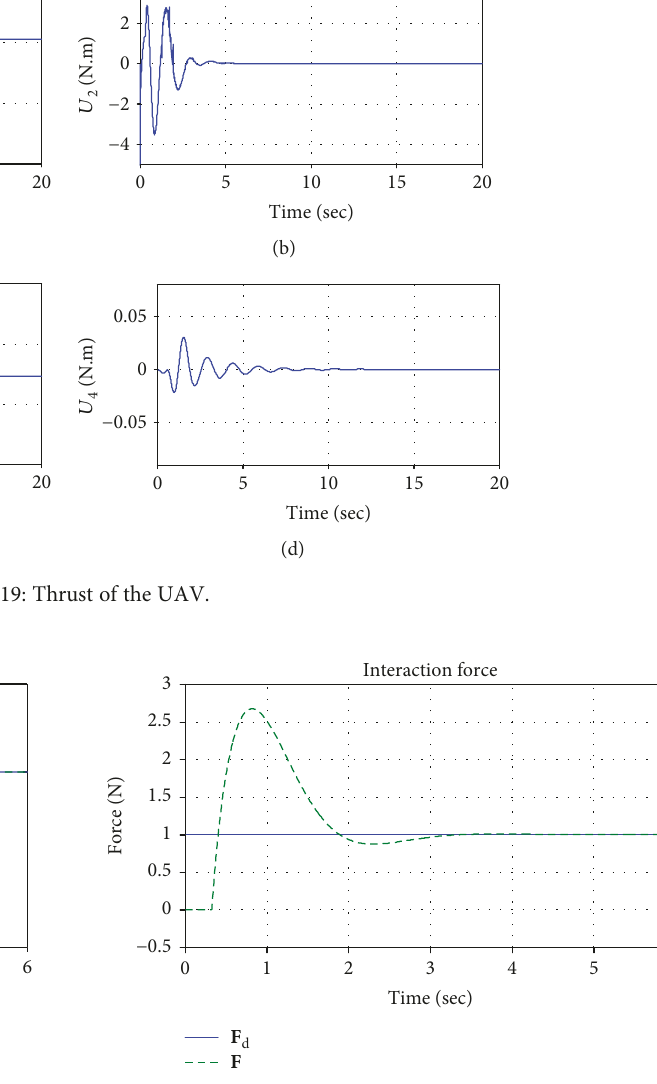
Figure 22: Interaction force between the end e ff ector and the surface.